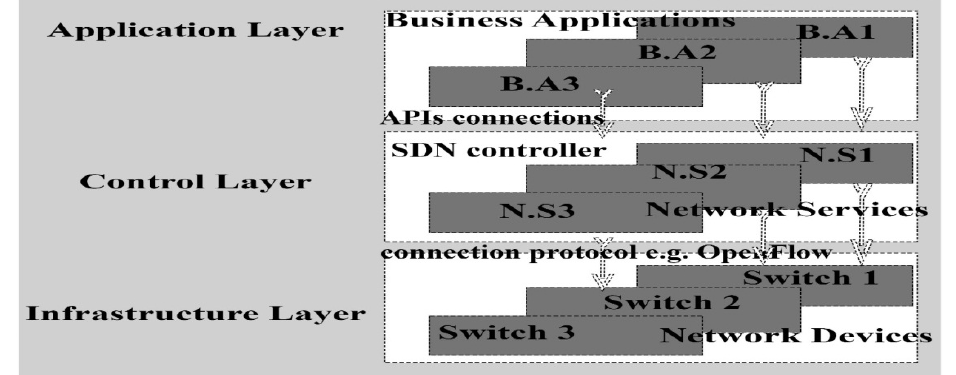
Figure 1. Structure of Software-Defined